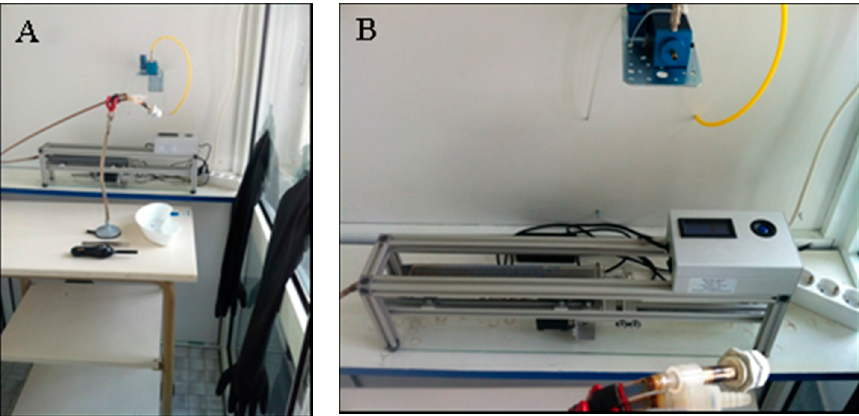
Figure 1. ( A ) The Automatic Environmental Tobacco Smoke Emitter (AETSE) in a glass chamber; ( B ) The AETSE in detail: a 200 mL glass syringe, a stepper motor, a microcontroller and stand equipment.